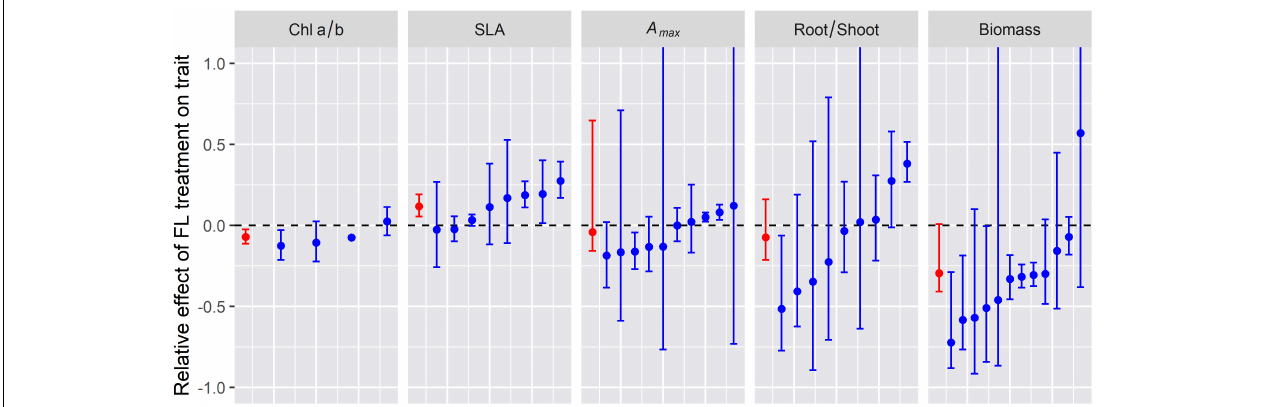
FIGURE 2 | Relative effect of fluctuating irradiance (FL) treatment on plan traits for the different experiments reviewed (blue symbols and error bars) and the average relative effect across experiments (red symbol and error bars). Error bars indicate 95% confidence intervals (i.e., the 2.5 and 97.5% of the distribution of relative effect) whereas symbols indicate the median relative